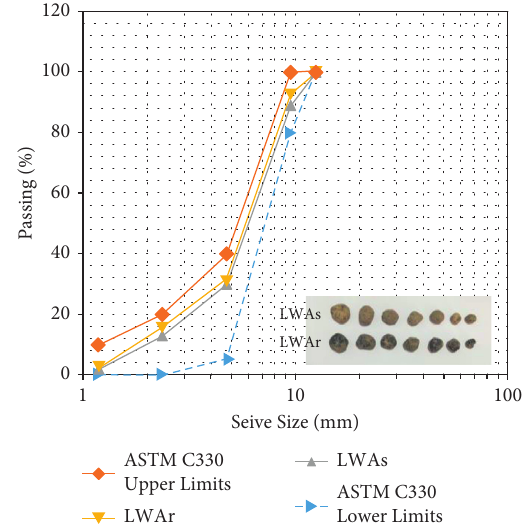
Figure 2: Sieve analysis of the smooth (LWAs) and rough (LWAr) lightweight aggregate